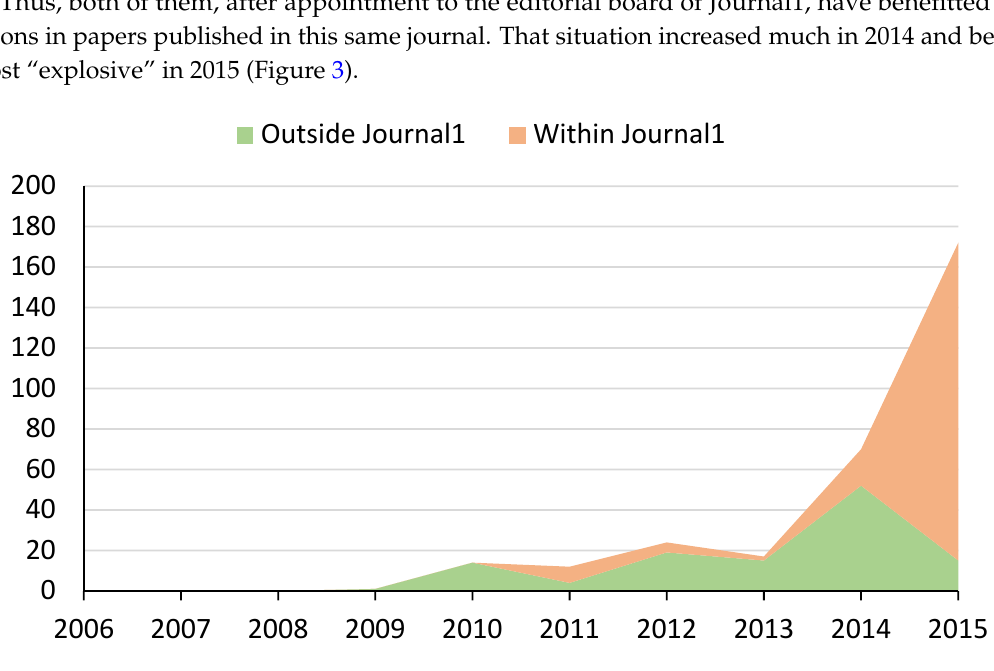
Figure 3. Citations of Author2’s papers in WoS distinguishing between citations of Author2’s papers, wherever published, whether cited or not in Journal1.